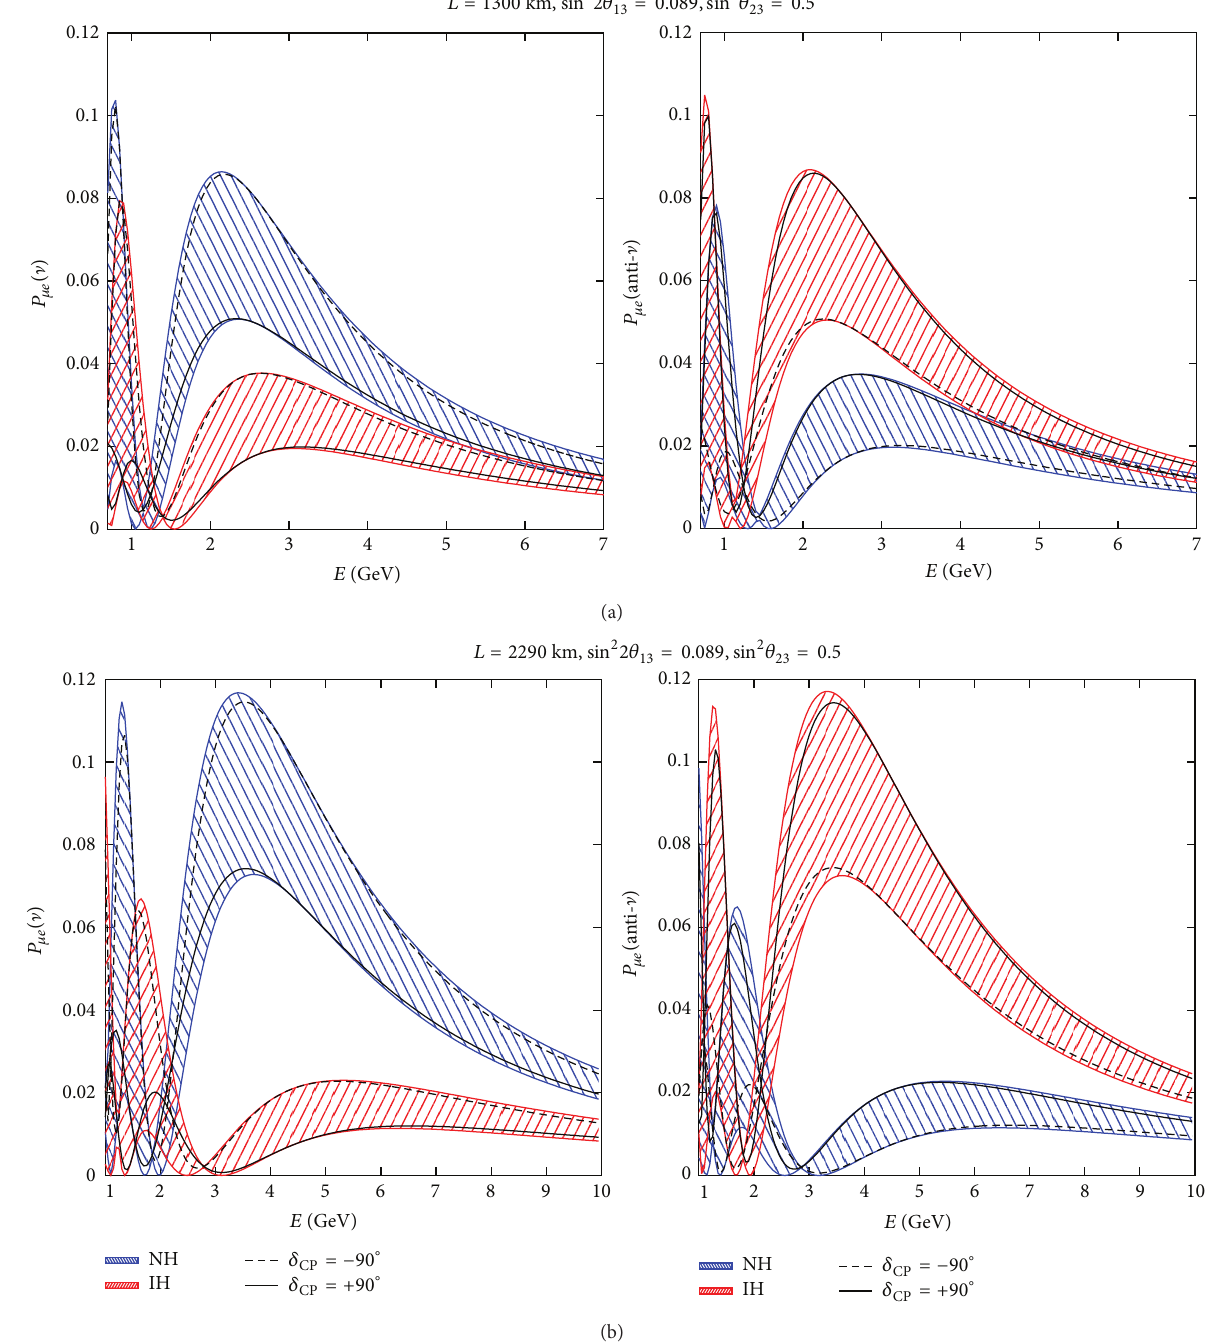
Figure 3: 𝑃 𝜇𝑒 as a function of neutrino energy. Here, the bands correspond to different values of 𝛿 = 90 ∘ ( 𝛿 = −90 ∘ ) case is shown by the solid (dashed) line. The blue (red) band is for NH (IH). The left panel (right the probability for 𝛿 CP CP panel) is for ] ( ] ). The upper panels are drawn for the LBNE baseline of 1300 km. The lower panels are for the LBNO baseline of 2290 km. Here, we take sin 2 2𝜃 13 = 0.089 and sin 2 𝜃 23 = 0.5